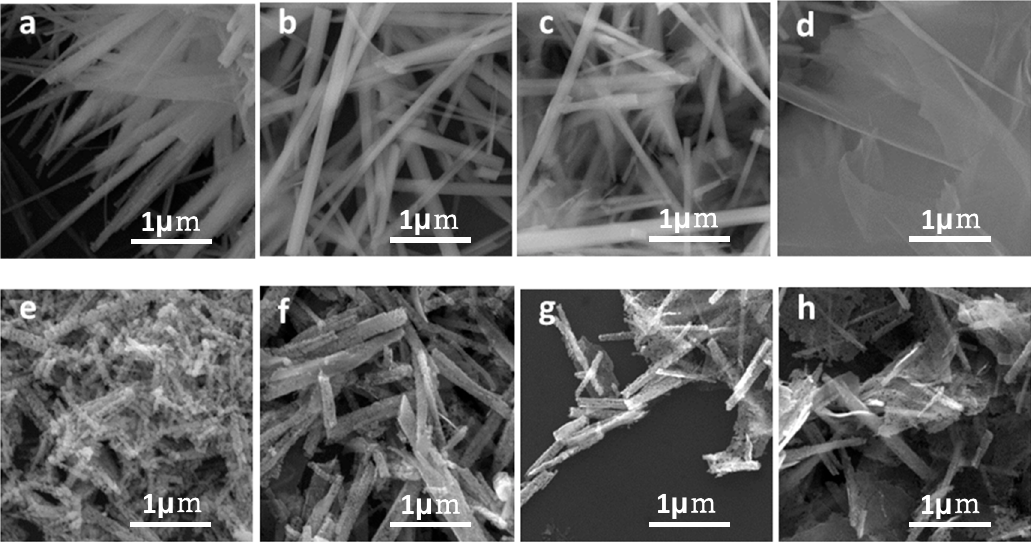
Figure 5. SEM images of ( a – d ) different precursors prepared by different Ni/Co molar ratios, and ( e – h ) the corresponding oxides.